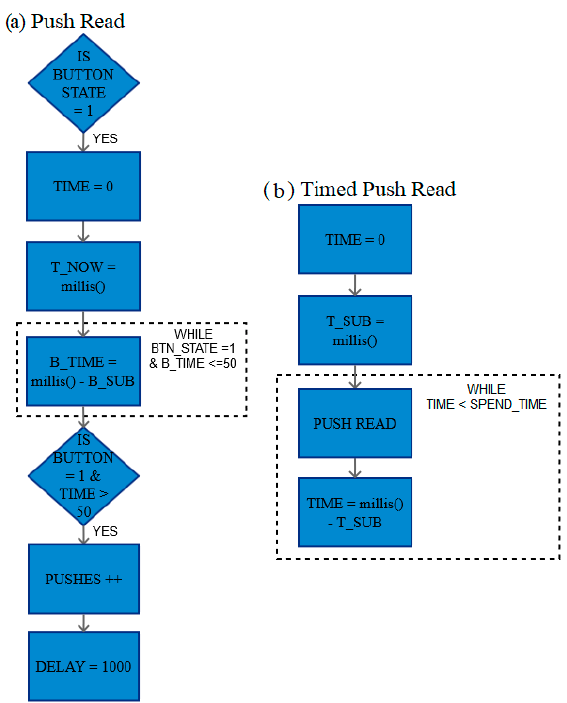
Figure 12. Block diagram of: ( a ) push read and ( b ) timed push read blocks.